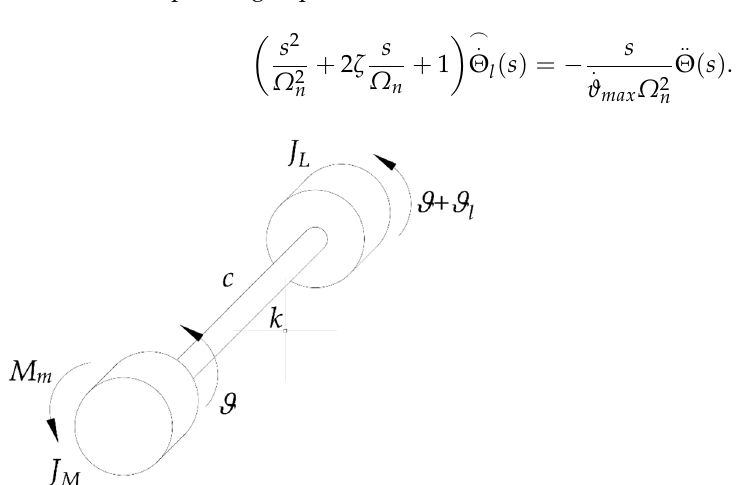
Figure 1. Model of the oscillating system.